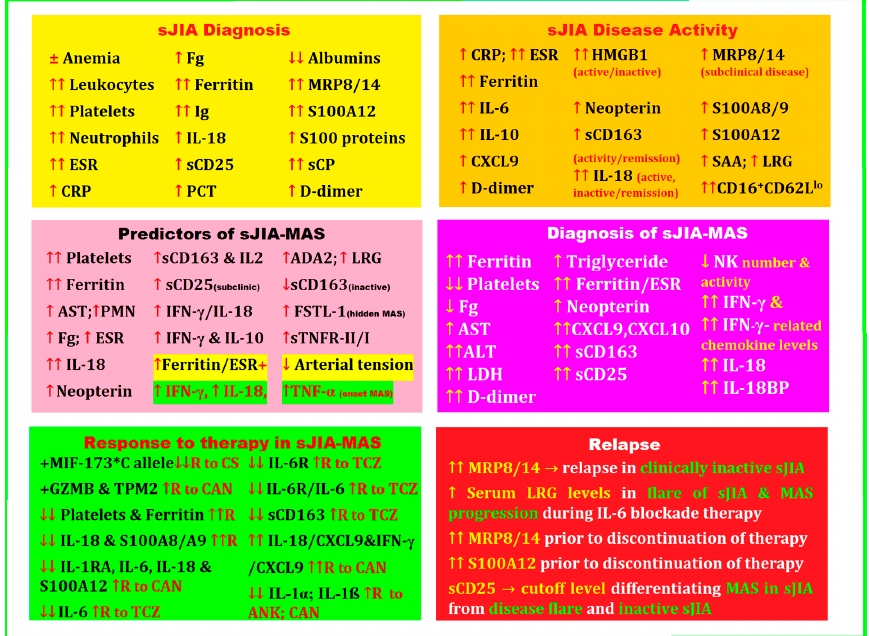
Figure 1. Biomarkers in sJIA and sJIA-MAS: diagnosis; disease activity; predictors of sJIA-MAS; diagnosis of sJIA-MAS; response to therapy in sJIA-MAS; and relapse. (Figure 1 was conceptualized and drawn by L.M.A. using Microsoft Paint 3D for Windows 10). Legend: [ ↑ = increasing/high; ↑↑ = very high; ↓ = decreasing/low; ↓↓ = very low; “+” = present; ± = present/absent; R = response].